Question: In one sentence, what is this figure communicating?
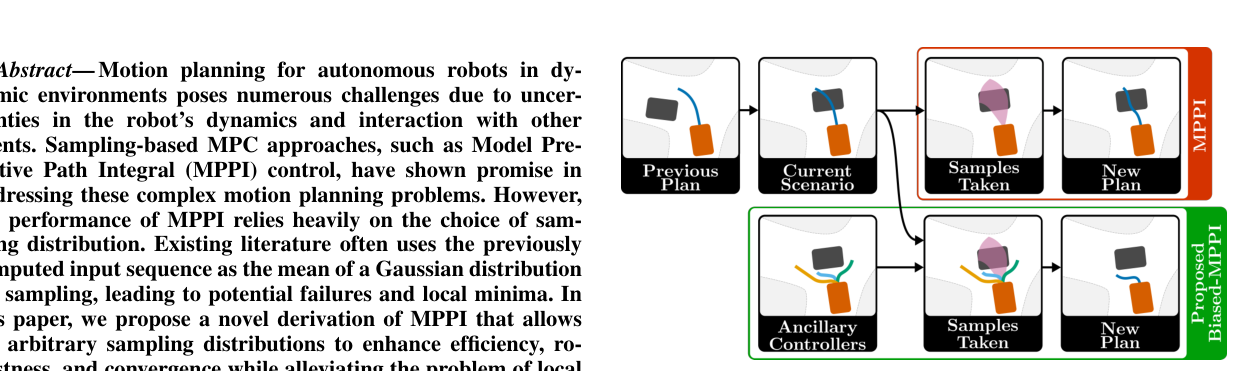
Answer: Top: Usually, MPPI only takes samples around a pre- vious plan. Here, the environment changes unexpectedly, and all the sampled trajectories are in collision, which leads to computing a new plan that also collides. Bottom: our Biased- MPPI adds ancillary controllers to the sampling distribution, quickly converging to a collision avoidance maneuver.